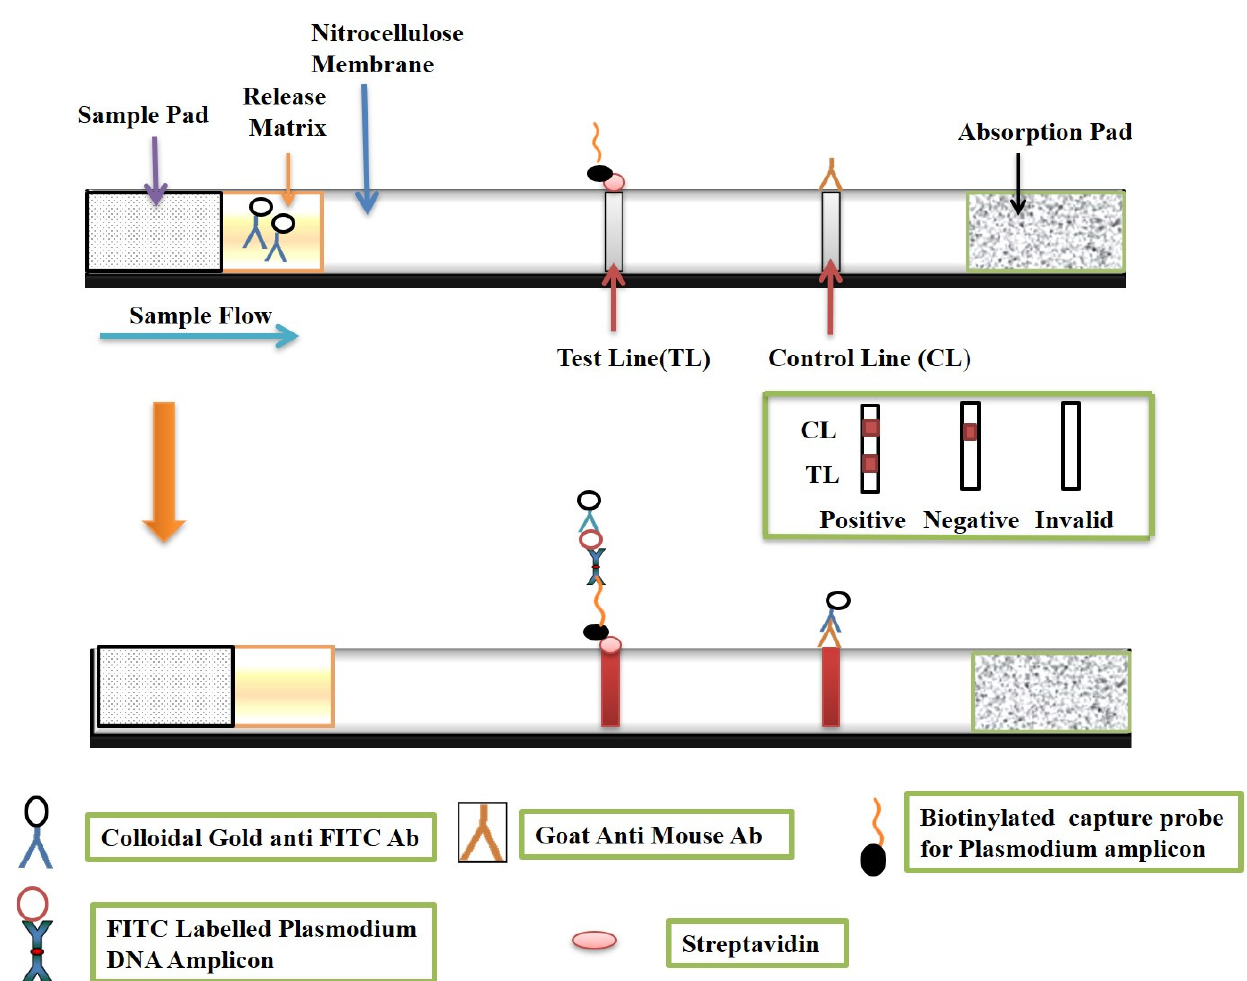
Figure 2. Schematic representation of lateral flow strip principle and its